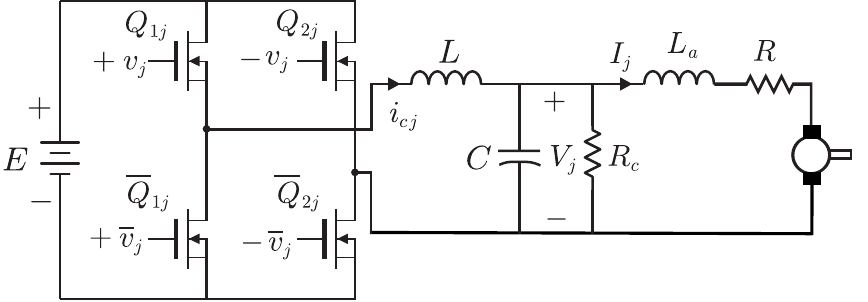
Figure 2. The inverter-DC/DC Buck power electronic converter-DC motor